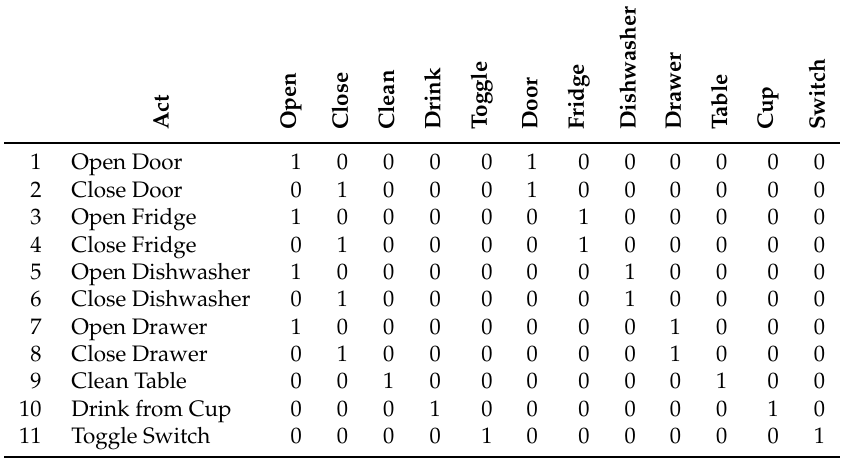
Table A3. Attribute vectors of the OPP dataset from [15].